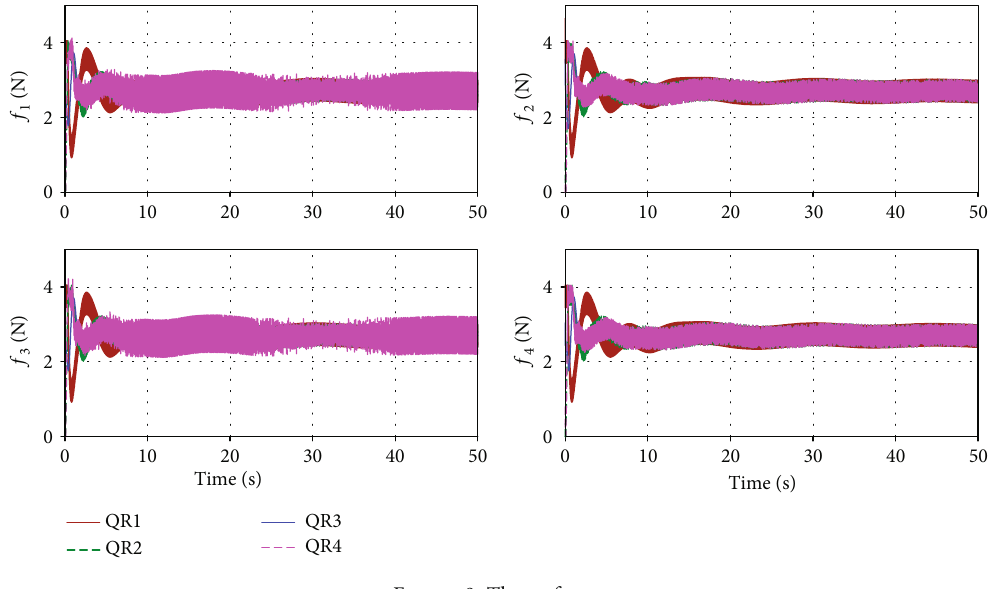
Figure 9: Thrust